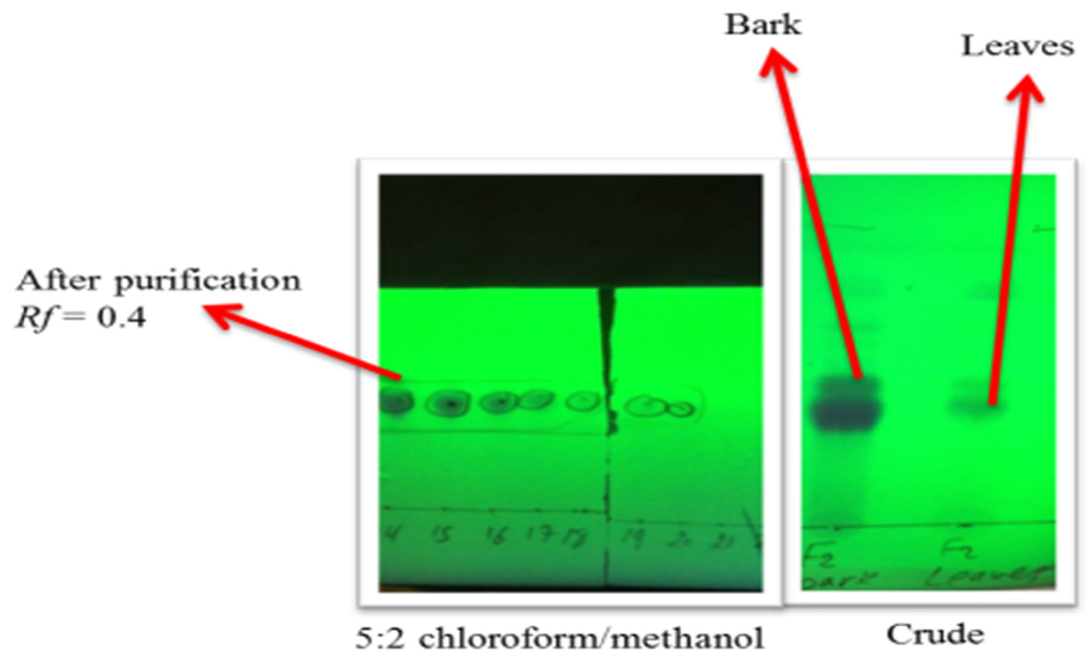
Figure 14. Possible evidence for isoflavonoid isolated from the bark and leaves of gorse.